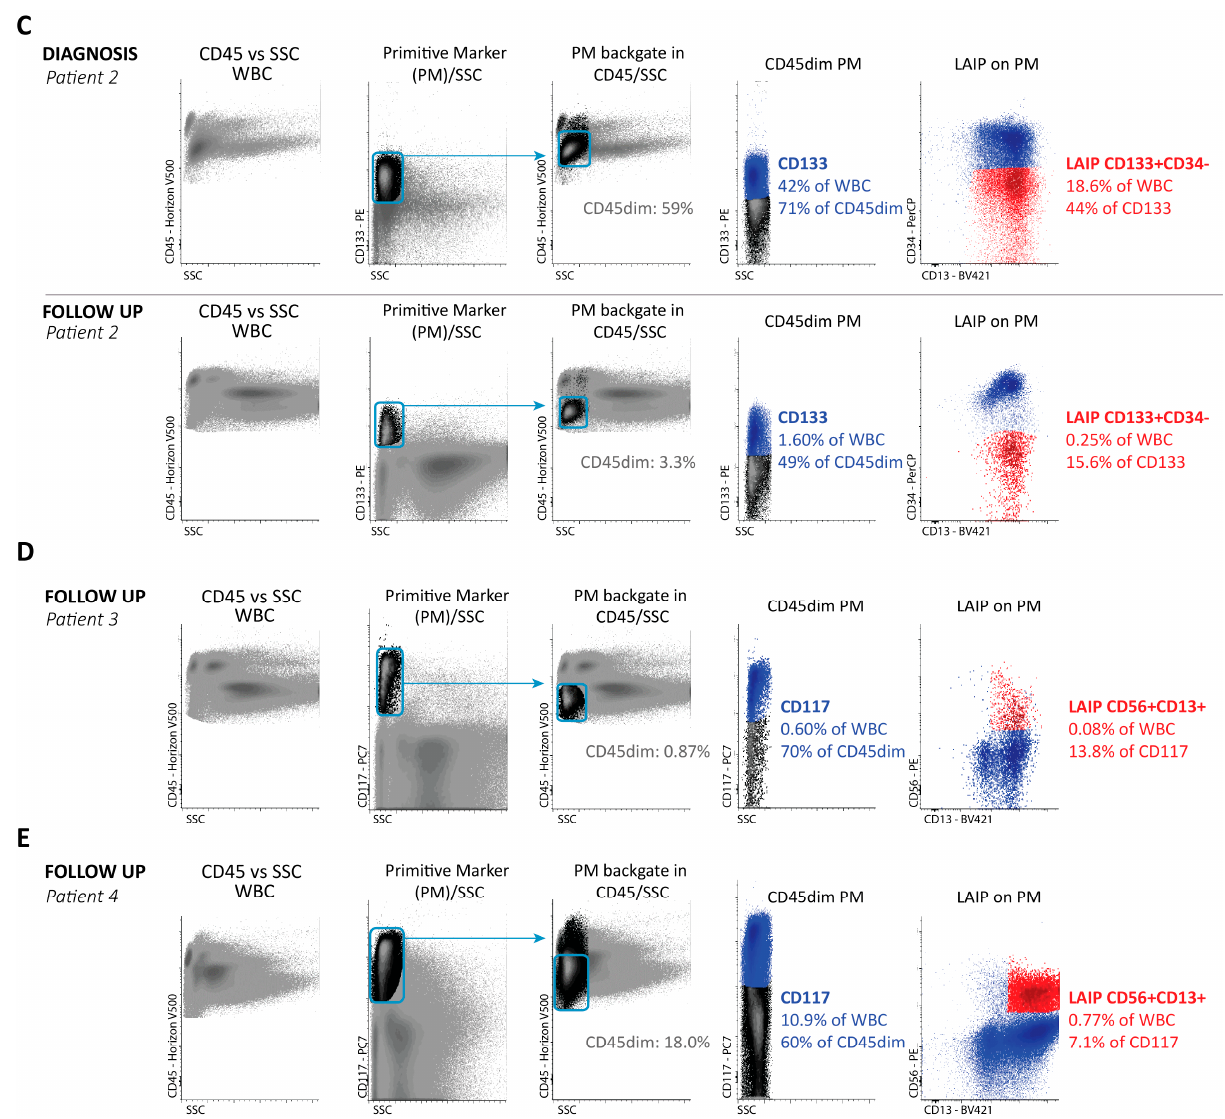
Figure 1. Flow cytometric examples of WBC-MRD/PM-MRD. Gating is described in more detail by Cloos, et al. [23] and Zeijlemaker, et al. [39]. ( A ) Gating of progenitor populations and LAIPs at the time of diagnosis (diag) in one patient (patient 1). First panel: WBC in CD45/SSC; first row: gating for CD34 and CD34+ LAIPs; second row: sequential backgating in CD45dim/SSC and CD34/SSC of the LAIP+ population—this is only shown for this CD34 LAIP, but this sequential backgating of LAIP+ populations was performed in all cases (so also below for CD117 LAIPs and CD133 LAIPs) in CD45dim/SSC and PM/SSC and, where necessary, also in FSC/SSC; third row: gating for CD117. ( B ) Gating on patient 1